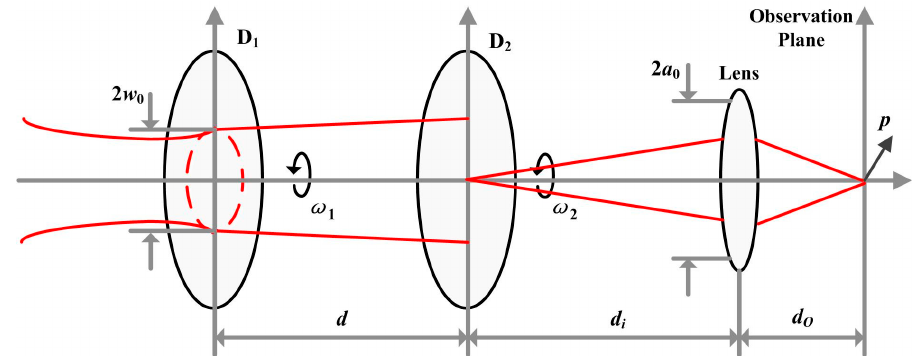
Figure 1. Optical schematic of doubly scattered system.